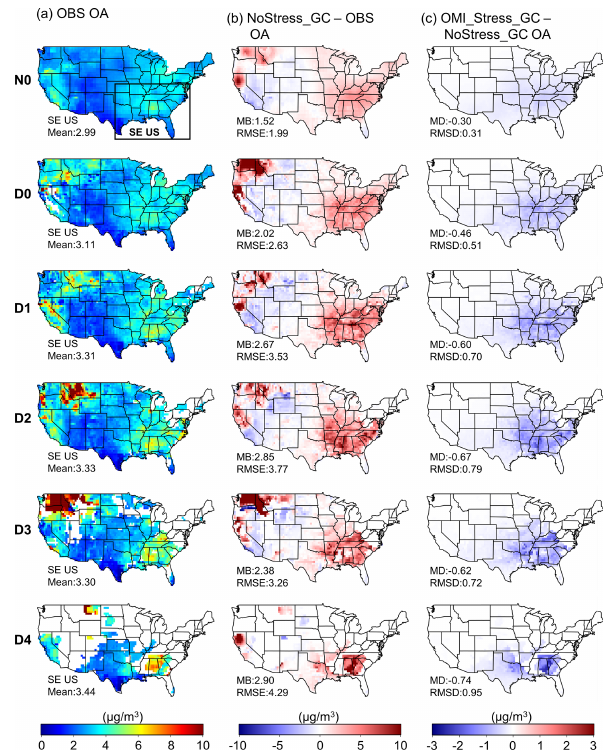
Figure 12. Same as Fig. 10 but for organic aerosol